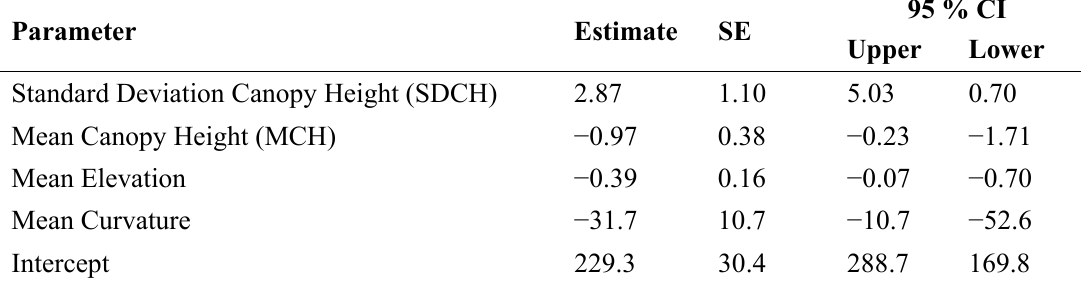
Table 1. Non-spatial generalized least squares (GLS) model of species richness at 1.0-ha scale with lidar-derived canopy height and topography covariates. The table includes coefficient estimates, standard errors (SE), and boundaries of the 95% Confidence Intervals for each parameter. This model was parameterized with field and lidar data from the Barro Colorado Island (BCI) 50-ha forest dynamics plot (FDP). Parameter Estimate SE Standard Deviation Canopy Height (SDCH)